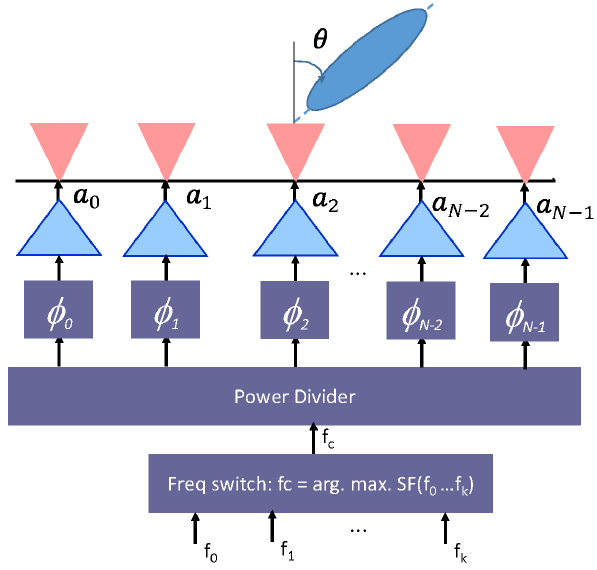
Figure 2. Diagram of an N-Element tunable beamforming circuit to be developed.